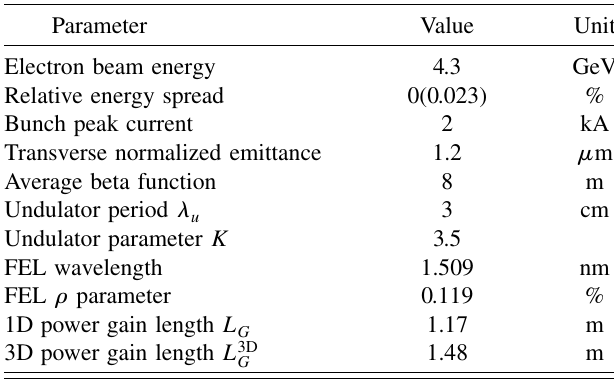
TABLE I. Main parameters for the LCLS soft x-ray FEL used in